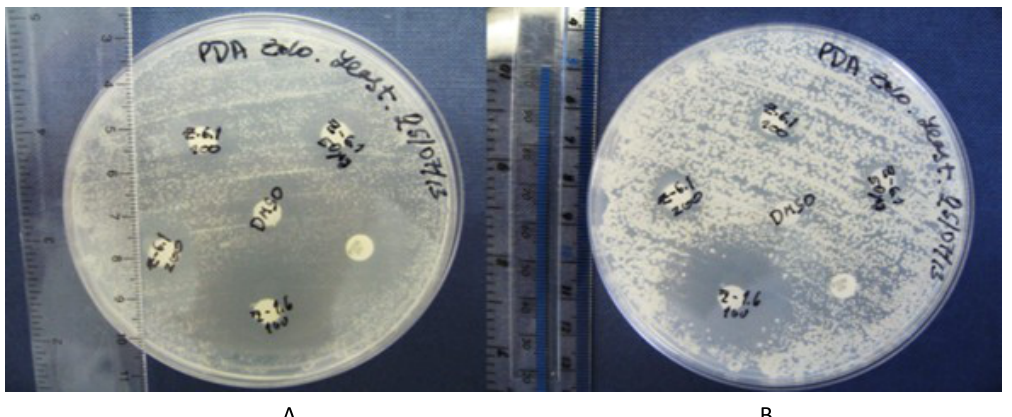
Fig. 1. Yeast plates. A - after 24 hours, B - after 48